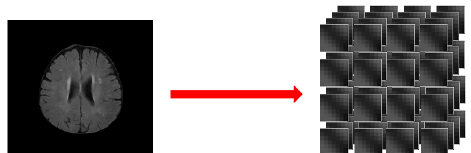
Figure 3. The proposed method architecture.